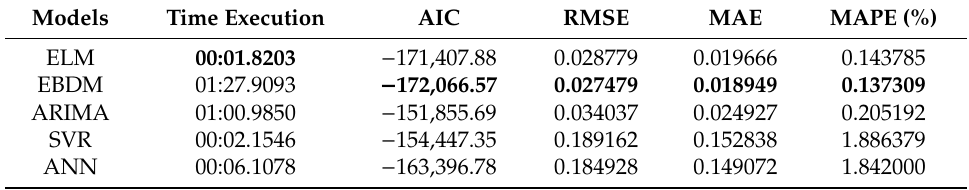
Table 3. Prediction performance comparison by AIC, RMSE, MAE, and MAPE (*). Models Time Execution AIC